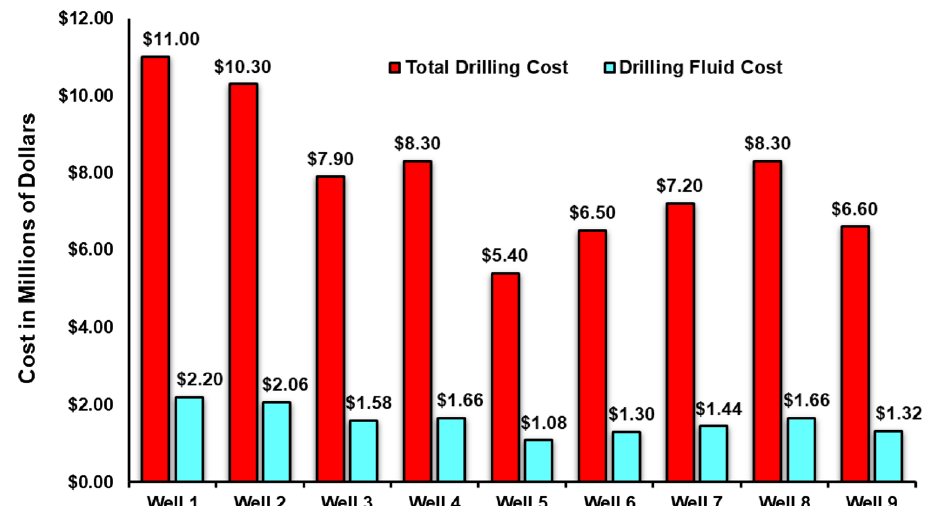
Fig. 15 The cost of the drilling fluid from the total cost of the drilling operations